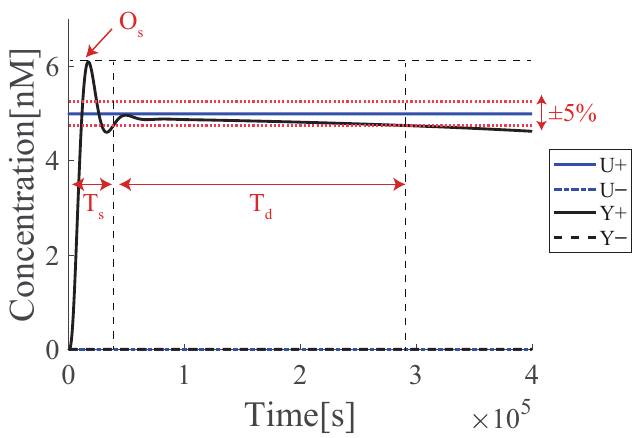
Figure 8. Performance indicators of DNA-PI controller.